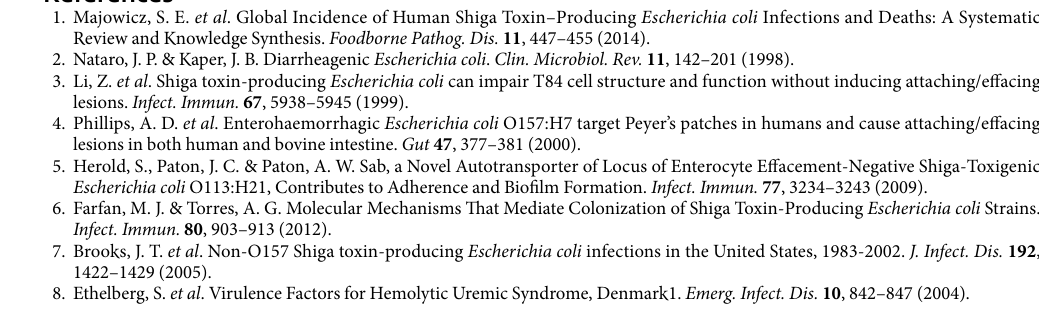
tively. Besides, the ORFs and the G + C content were determined by analyzing genomic sequences using Unipro GENE 50 and the Geneious software package (v10.0.9; Biomatters Ltd). DNA with PAI features were used to per- formed BLASTn searches against the Pathogenicity Island Database v2.0 34 . Also, a local BLASTn search was per- formed in the Geneious software package to determine the distribution of LAA modules and their insertion sites in the genomes analyzed. Multiplex PCR